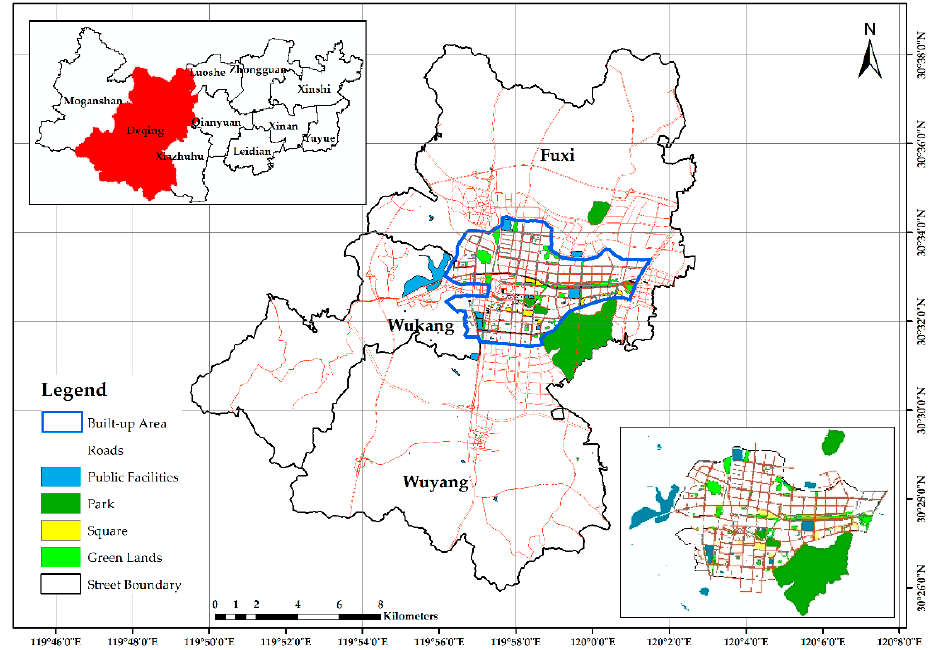
Figure 1. Built-up areas and geographic location of Deqing County.